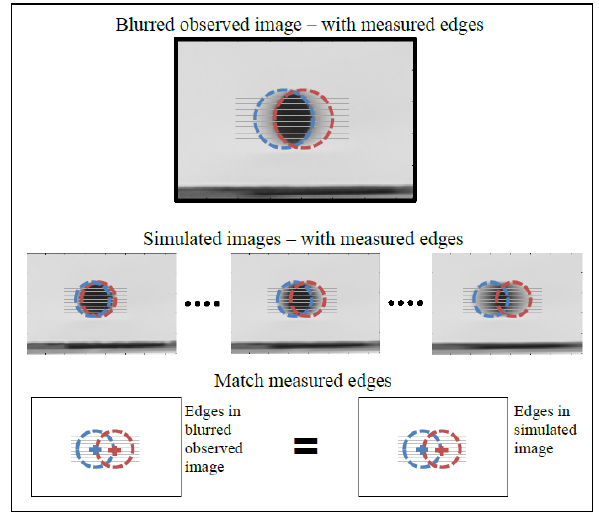
Figure 1. Motion-blurred target measurement